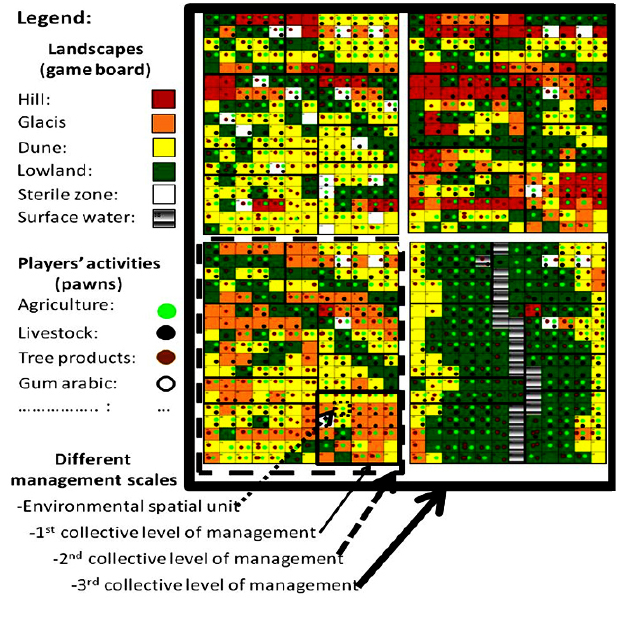
Fig. 5 . The multiscale structure of the model. The players- users can move around on a map, move from one map to another, and from one season to another depending on their needs. Because participants can change maps depending on their context and scale, this multiscale representation enables different scales to be modeled depending on the range of scales chosen by the participants: the spatial unit selected can be a farm parcel, all the land belonging to one farmer, or even a local landscape. At the 2nd level, the spatial unit can be all the land belonging to a farmer, a communityÂ’'s territory, or even a region. At the 3rd level, the spatial unit can be a region, a whole country, or even an international